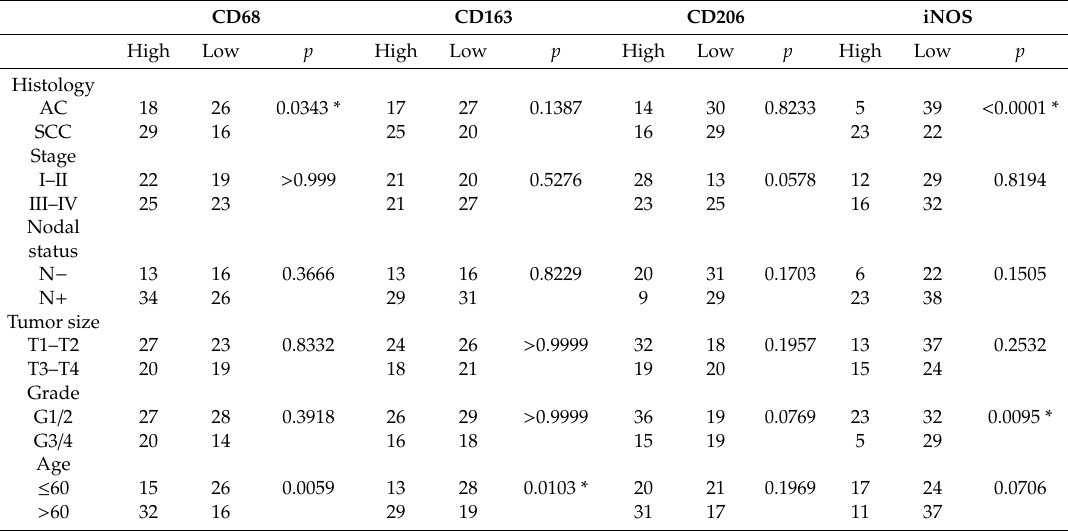
Table 2. Analysis of clinicopathological characteristics of tumors and TAM markers.